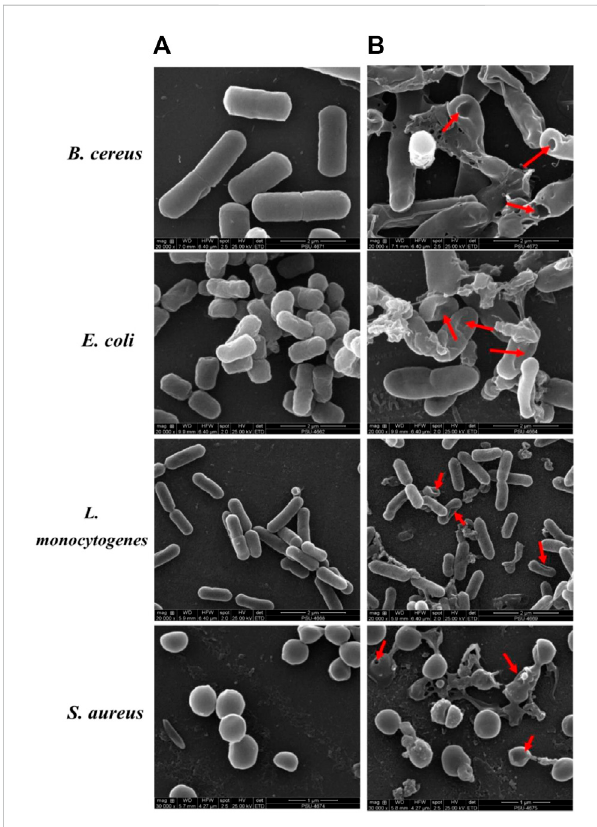
FIGURE 11 Scanning electron micrograph of MNPs treated foodborne bacterialisolates.Showingunruptured (A) andrupturewith damageof bacterial cell membrane after treatment with a bactericidal concentration of MNPs for 4 h (B) . Reproduced with permission from Nwabor et al. (2021a). Copyright 2021, Springer